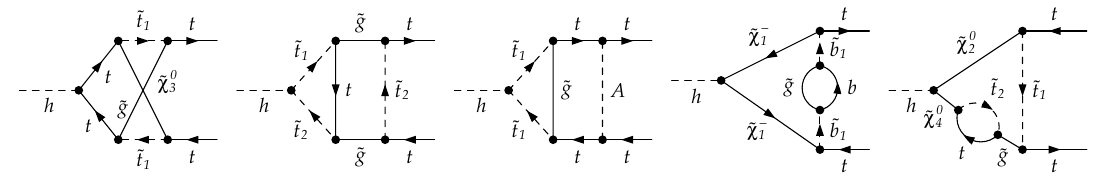
Figure 2. Sample diagrams contributing to (cid:16) hqq